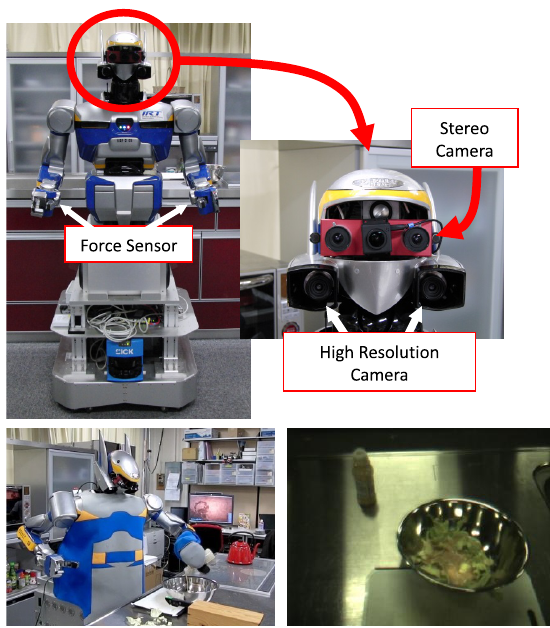
Figure 1. A life-sized robot working for making a salad